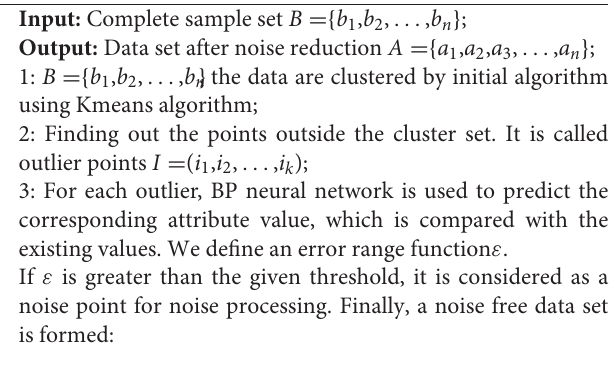
Algorithm 3: Data denoising